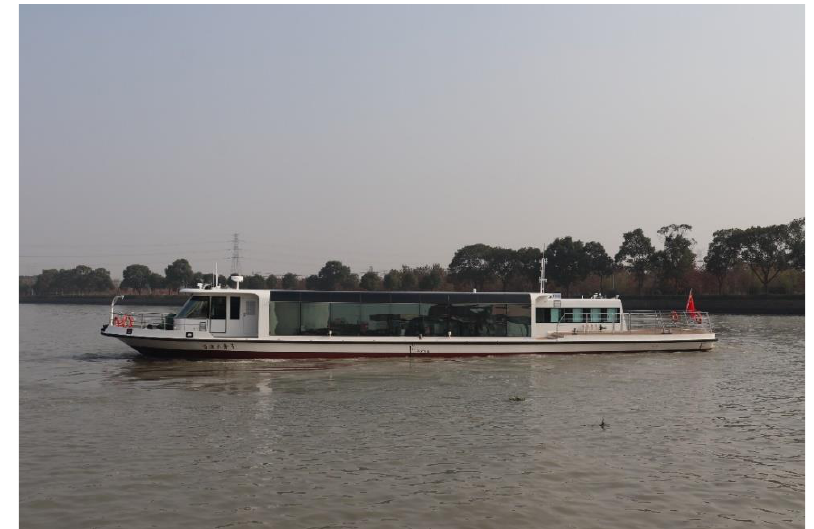
Figure 3. Inland river fast official patrol ship. Table 1. Ship parameters.